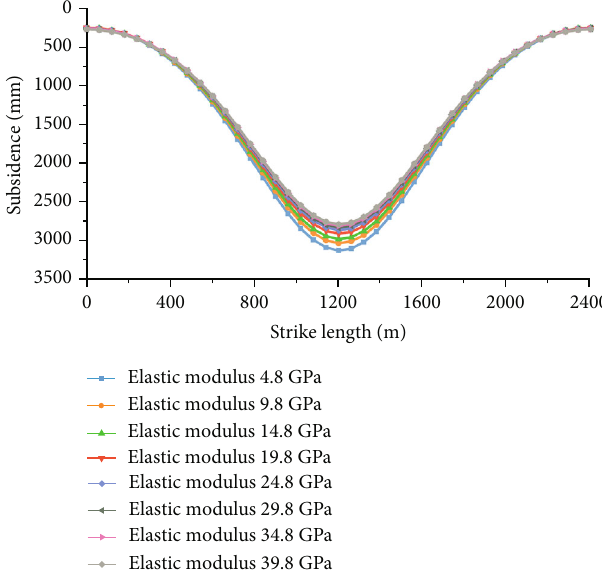
Figure 12: Surface subsidence curve of di ff erent elastic modulus in strike direction.